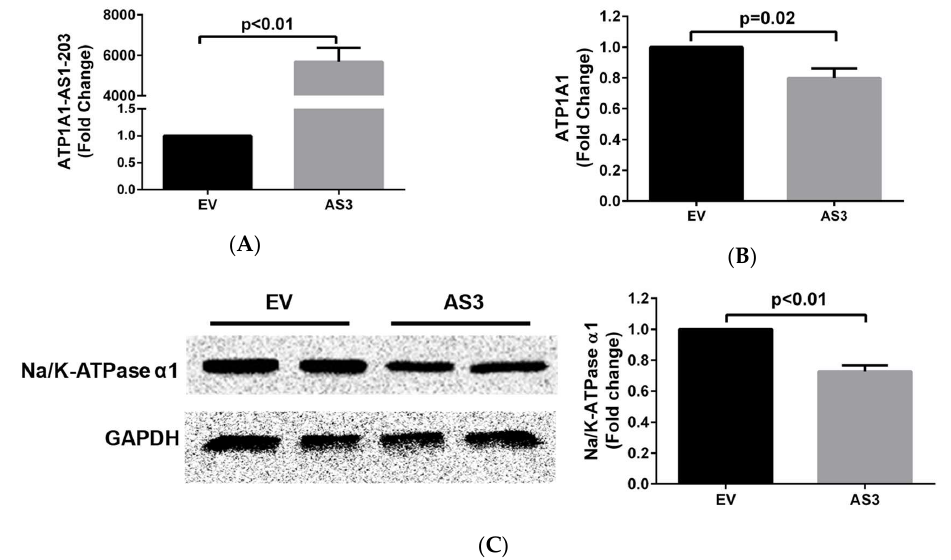
Figure 5. Overexpression of ATP1A1-AS1-203 negatively regulates ATP1A1 gene expression and Na/K-ATPase α1 protein level in HK2 cells. HK2 cells were transiently transfected with pcDNA3.1(-B) plasmid that overexpresses ATP1A1-AS1-203 (AS3) or empty vector (EV) for 48 h and expression of ATP1A1-AS1-203 ( A ) and ATP1A1 ( B ) were measured using RT-qPCR. The Na/K-ATPase α1 protein level ( C ) was measured by Western blot using the Radioimmunoprecipitation assay (RIPA) buffer resolved cell lysates. These experiments were repeated 4 times. Data was analyzed using t -test.